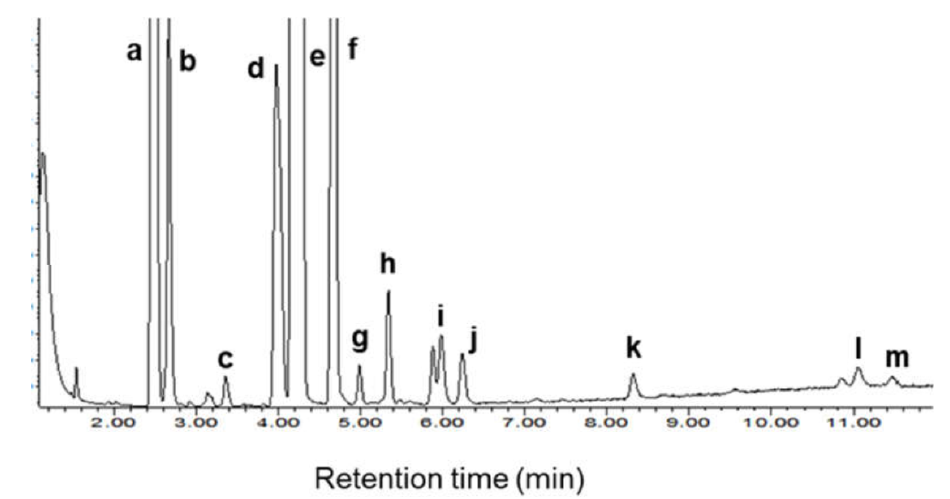
Figure 3. Chromatogram of transesterified fatty acids: myristic acid, 14:0 (a); myristoleic acid, 14:1 (b); pen-tadecanoic acid, 15:0 (c); palmitic acid, 16:0 (d); palmitoleic acid, 16:1 (e); heptadecanoic acid, 17:0 (f); stearic acid, 18:0 (g); oleic acid, 18:1 (h); linoleic acid, 18:2 (i); linolenic acid, 18:3 (j); eicosenoic acid, 20:1 (k); erucic acid, 22:1 (l); docosahexaenoic acid, 22:6